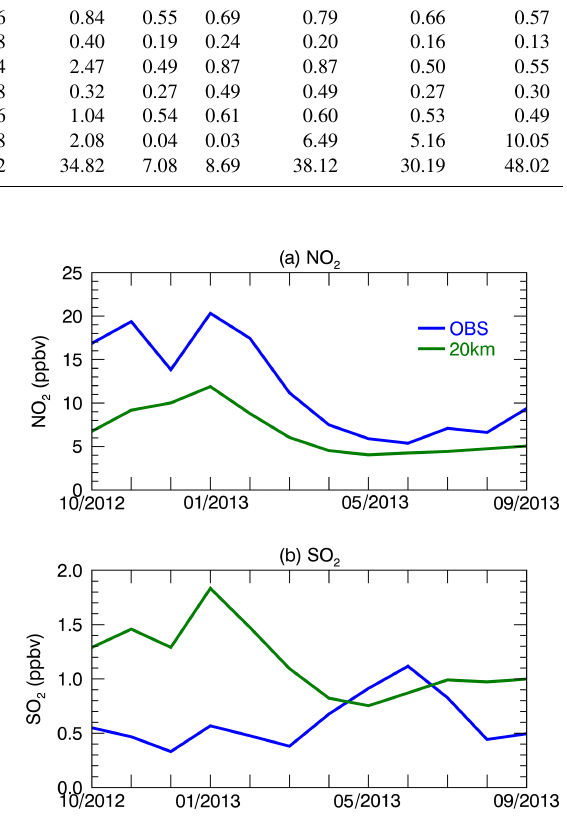
Figure 6. (a) NO 2 and (b) SO 2 from the EPA (OBS) and the 20km run at Fresno,